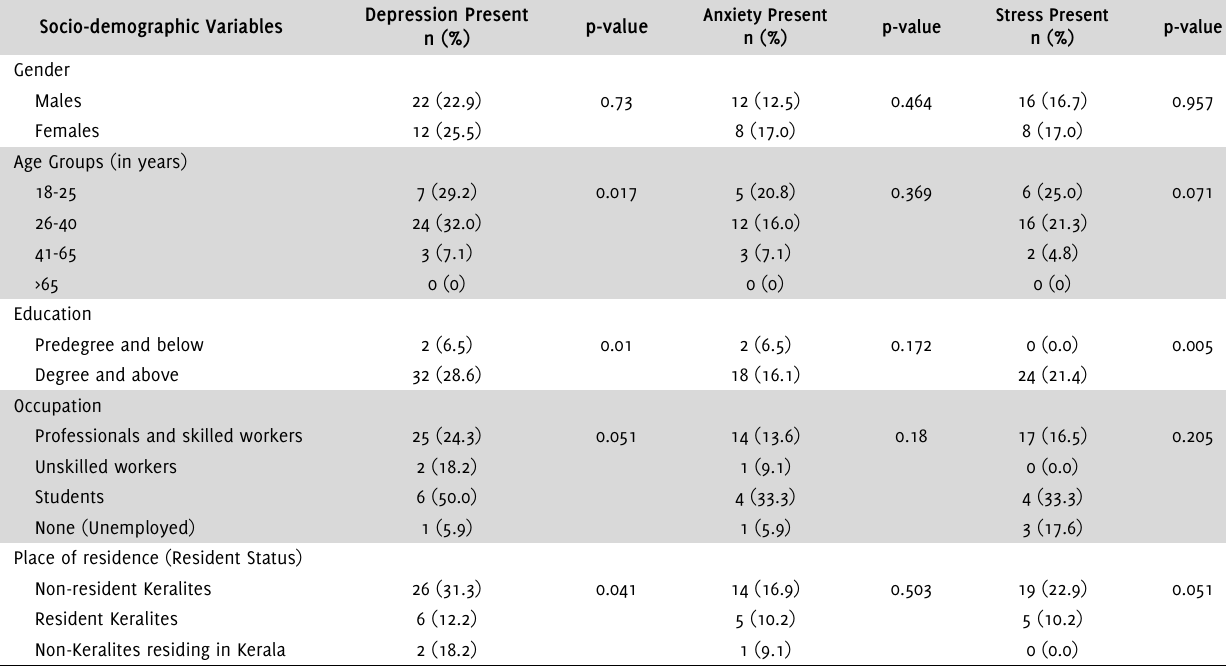
Table 2 . Associations of Socio-Demographic Factors with Depression, Anxiety, and Stress (n = 143). Socio-demographic